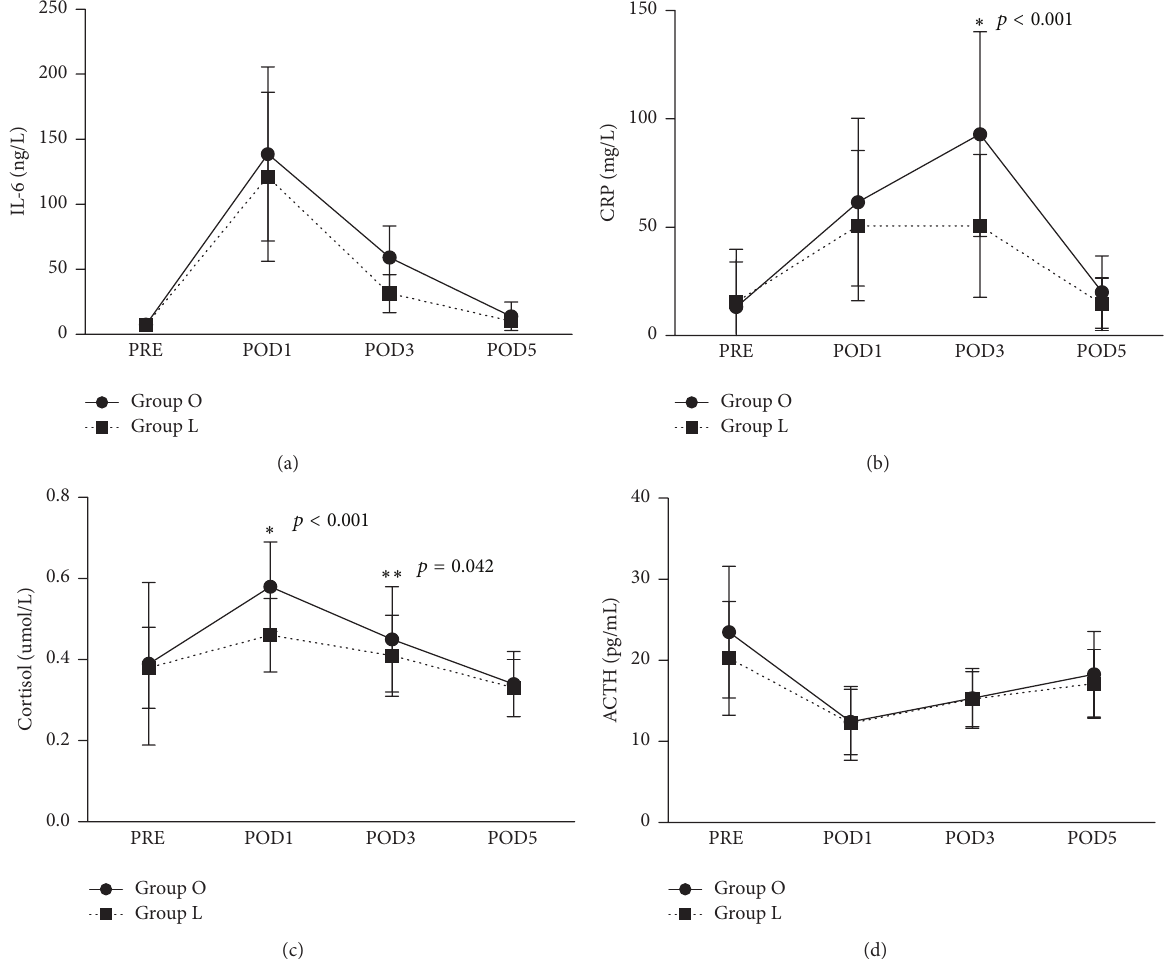
Figure 2: Evolution of inflammatory and stress markers levels. The 𝑝 values were calculated between Group O and Group L using t - test or Mann-Whitney U test. Asterisks ∗ and ∗∗ indicate statistical significance, and the 𝑝 values are shown. PRE: preoperatively; POD: postoperative